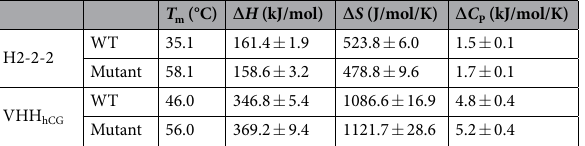
Table 2. Thermodynamic parameters of H2-2-2 and VHH hCG . For VHH hCG , T m and ∆ C P were quoted from ref. 22 and other thermodynamic parameters were calculated using published data 22